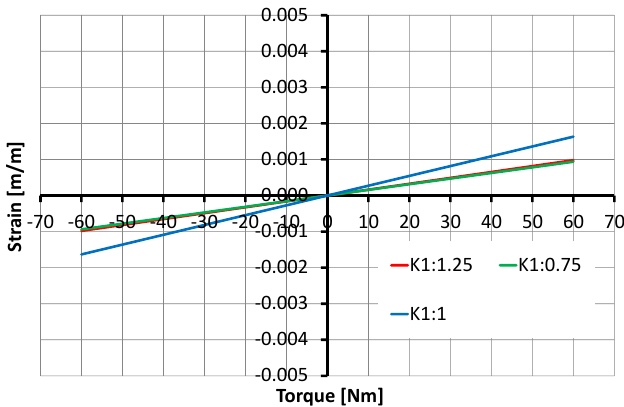
Figure 16. Relationship between the torque and the strain depending on design parameter K 1 : the 25% of variation influences torque sensor behavior.